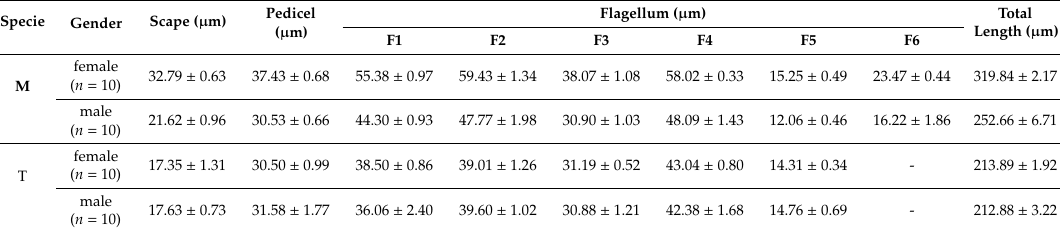
Figure 1. Morphology of antennae in female Megalurothrips usitatus and female Thrips palmi. ( a ) Megalurothrips usitatus. ( b ) Thrips palmi. Table 1. Mean length ( µ m) of antennal segments in Megalurothrips usitatus and Thrips palmi